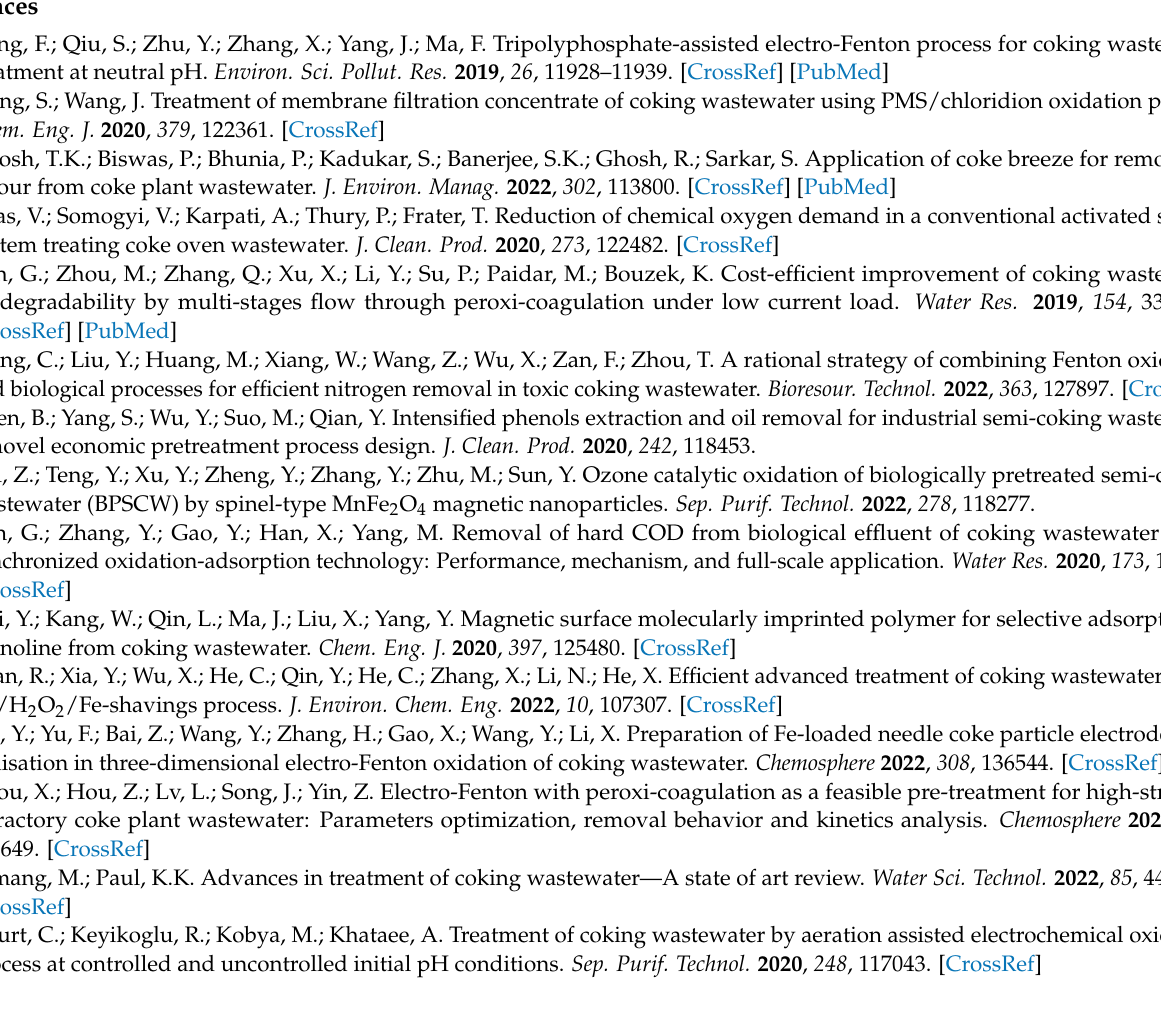
COD removal; Table S2: Physico-chemical properties of the tap water; Table S3: Physico-chemical properties of the lake water. Reference [34] is cited in the Supplementary